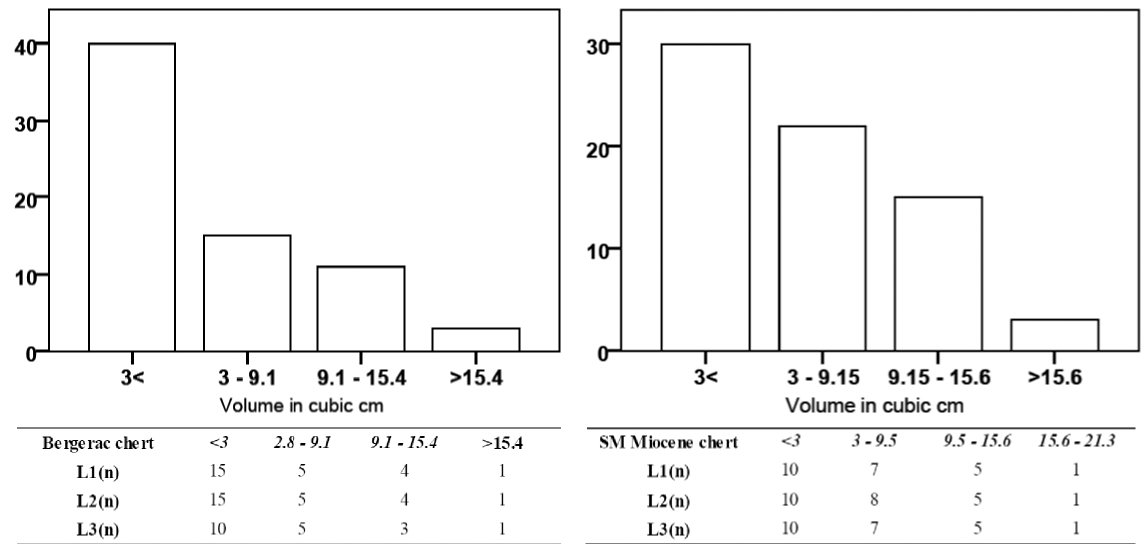
Figure 1. Volumetric distribution of blanks according to histogram results for blanks with a volume higher than 3 cm 3 and distribution among layers